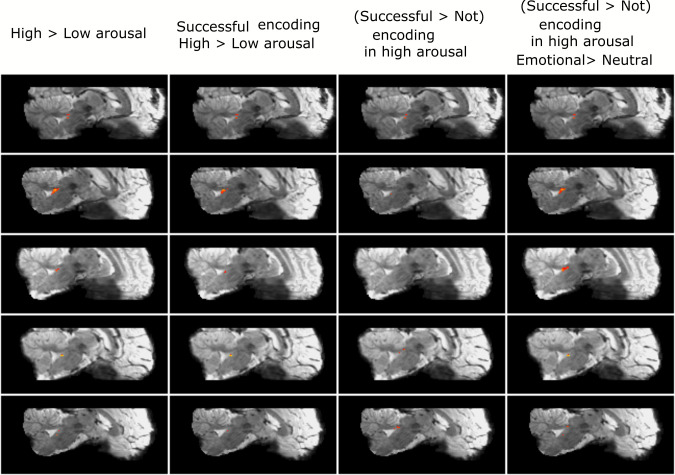
Individual brainstem results for the GLM contrasts during encoding.Note: Individual brainstem results for the GLM contrasts during encoding. Each column shows the brainstem activity at p<0.05 (uncorrected) for several contrasts during encoding and for five randomly selected subjects.